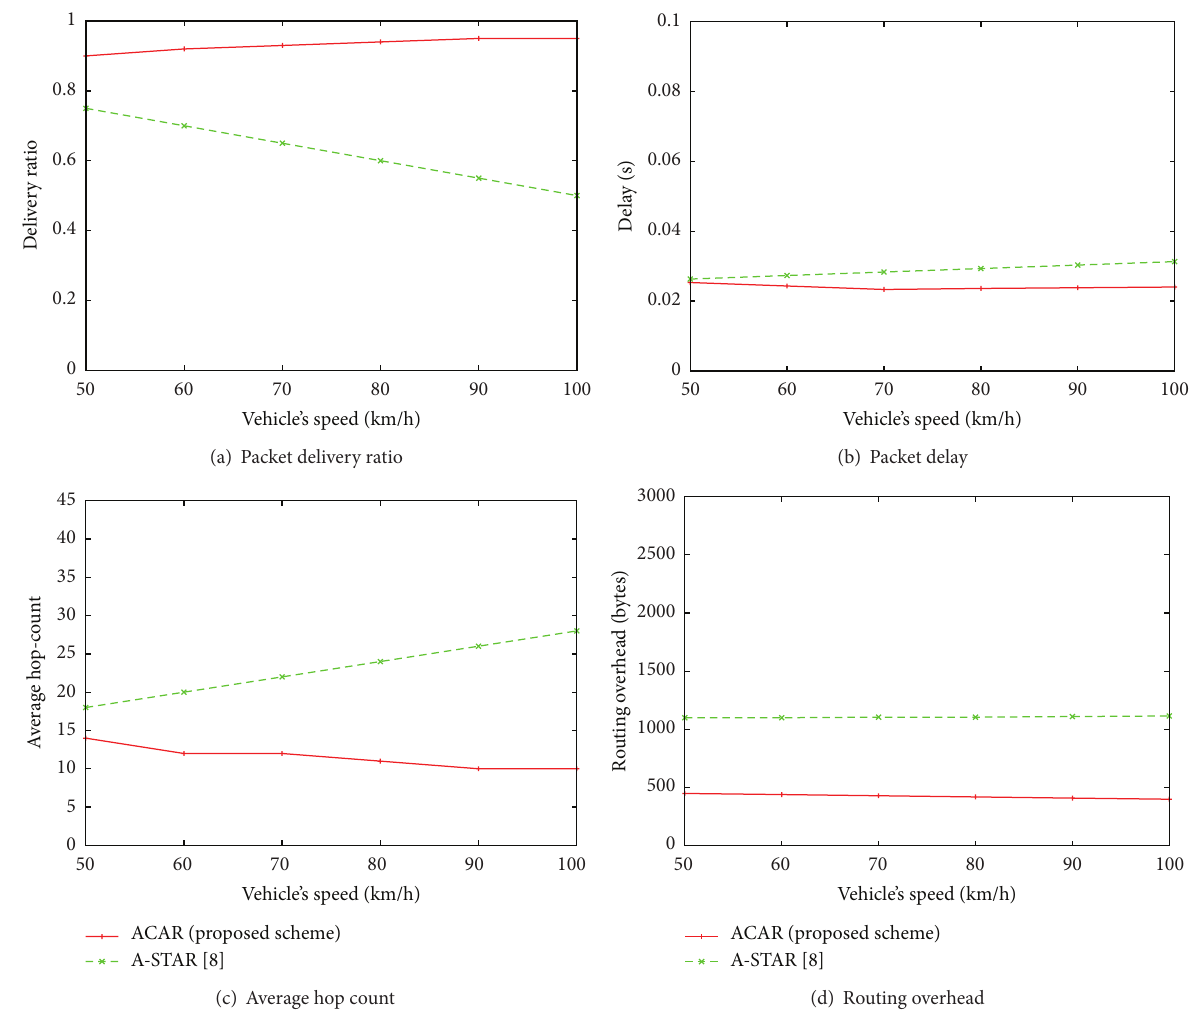
Figure 7: Performance comparison between ACAR (the proposed scheme) and A-STAR according to vehicle’s speed in terms of packet delivery ratio, packet delay, average hop-count, and routing overhead when the number of nodes is 100 and the radio range of node is 200